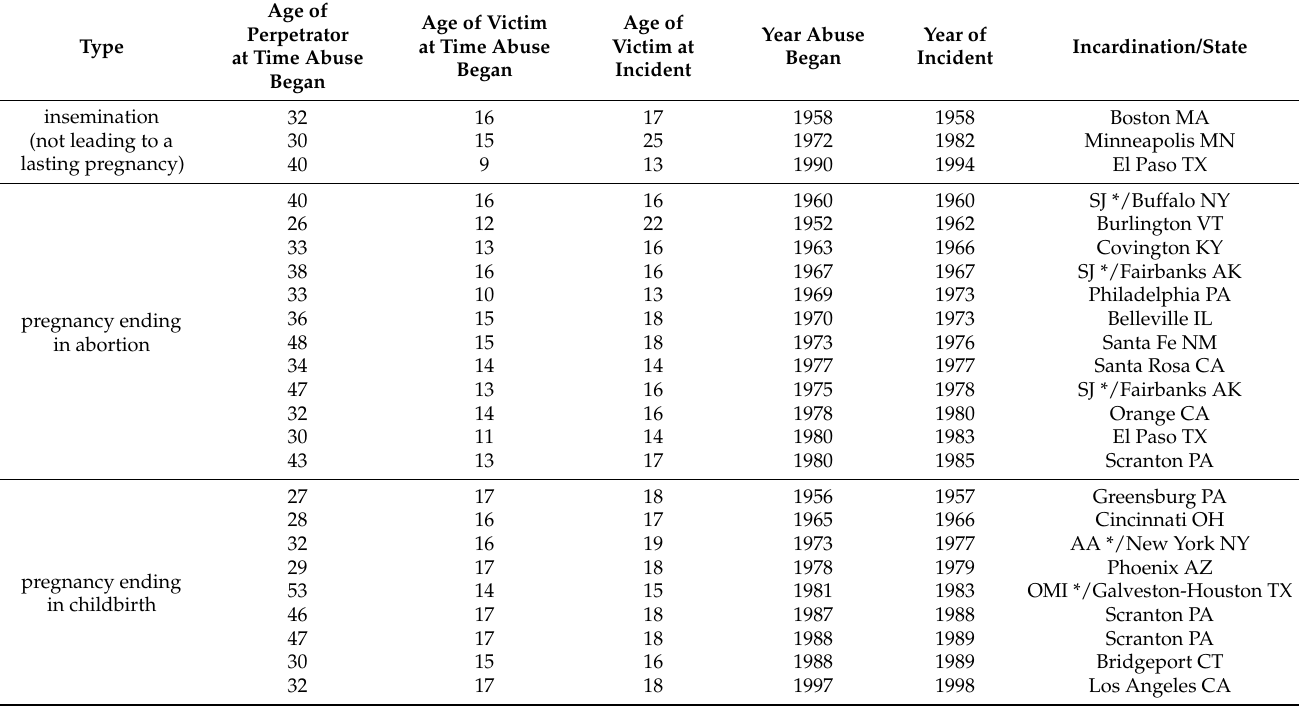
Table 1. Reproductive abuse cases documented in Bishop Accountability’s